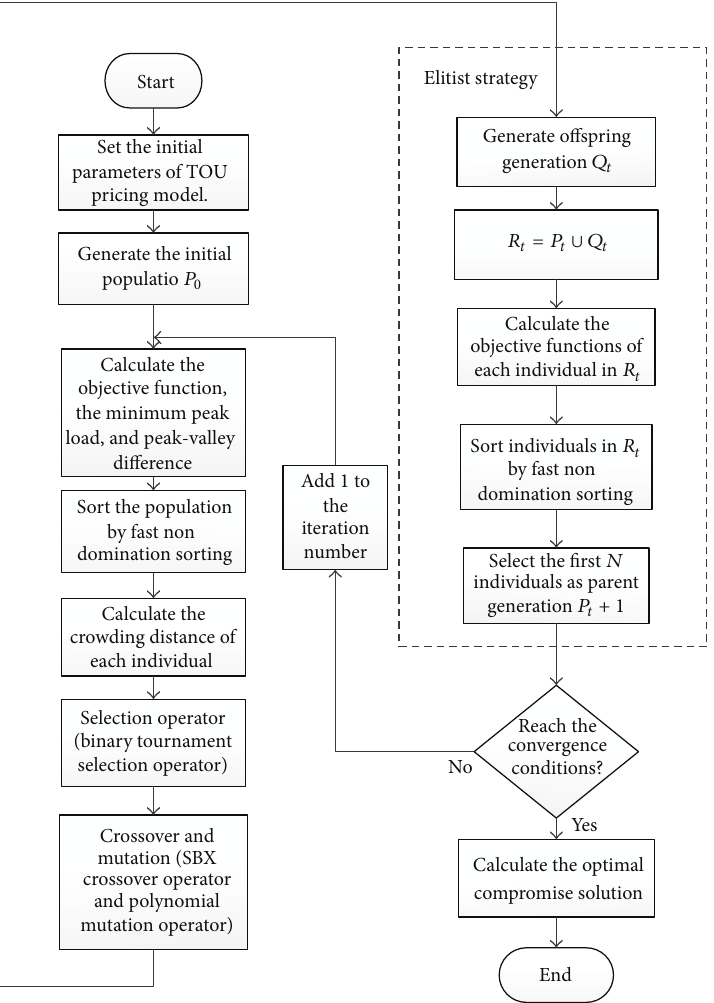
Figure 1: Flow chart of optimizing time-of-use price based on